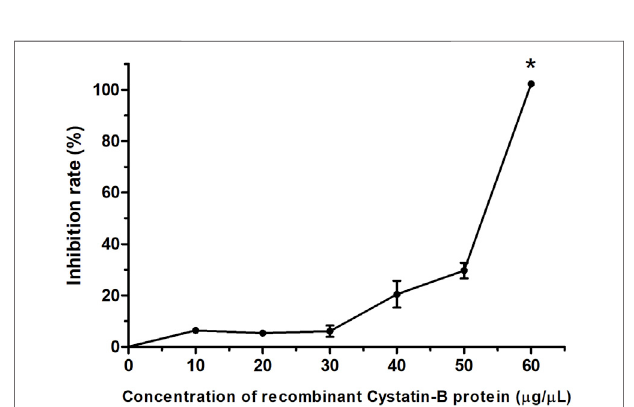
FIGURE 4 | Inhibition pattern of rCystatin-B against papain activity. The curve represents the change in residual papain activity along with the addition ofrCystatin-B. α GTH(negativecontrol),didnotshowanyinhibitoryeffect(data not shown). Values are shown as mean ± standard deviation from the mean ( n = 3). Asterisc (*) indicate statistical difference ( p =